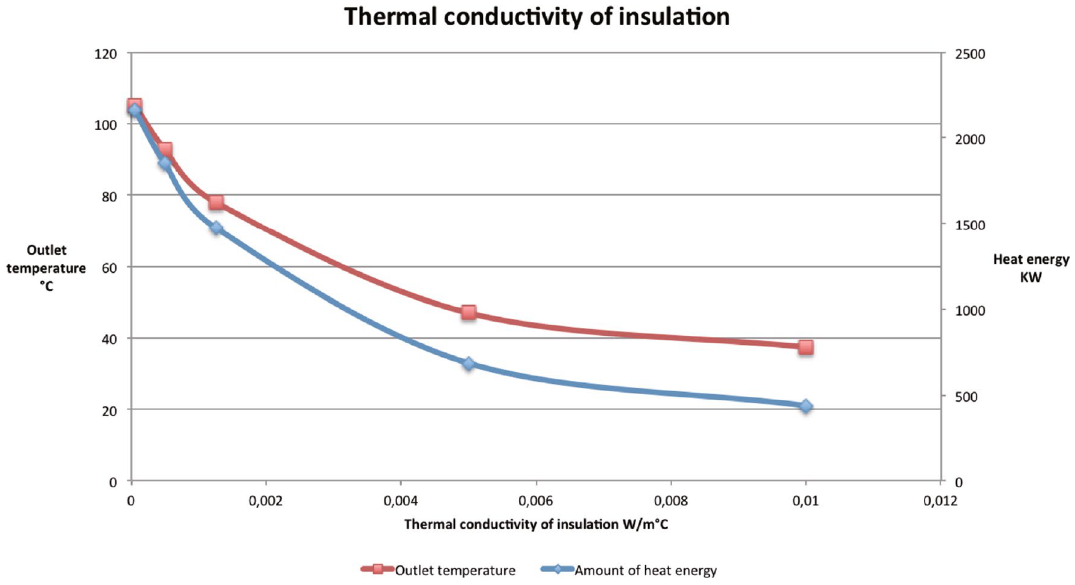
Fig. 7 Temperature and heat energy regarding thermal conductivity of